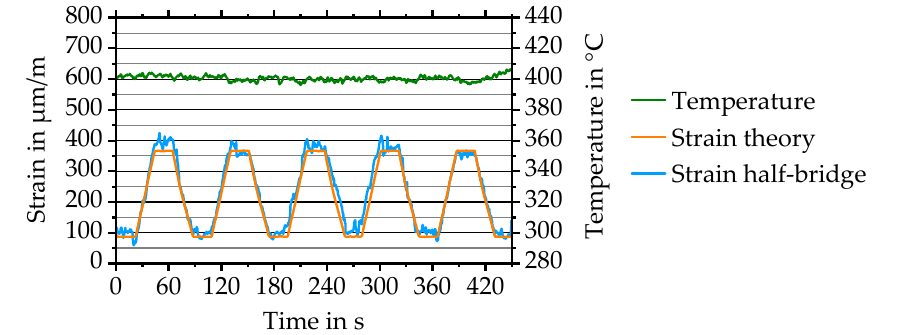
Figure 10. Theoretical strain and measured strain of a directly deposited half-bridge at cyclical loading between 500 and 2,000 N at 400 °C.